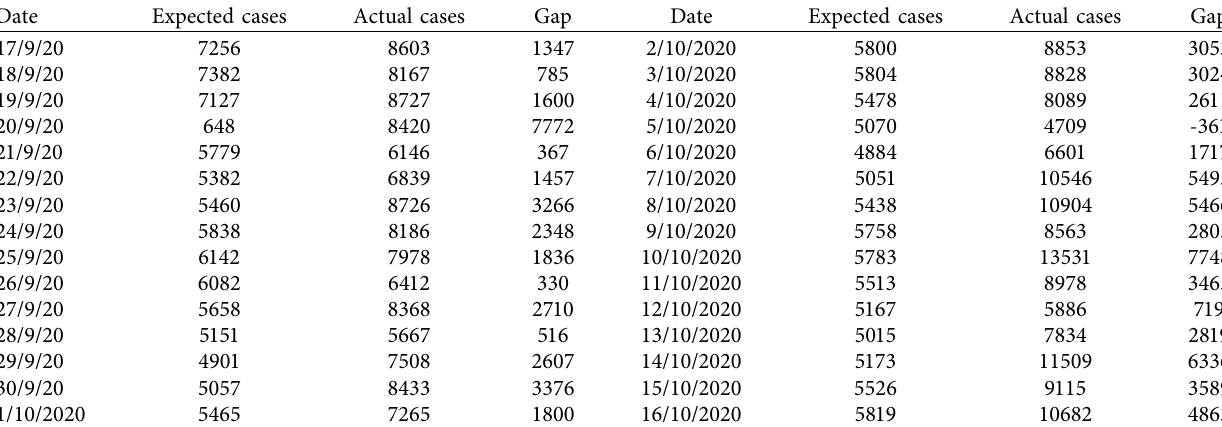
Table 9: The deviation between the actual and forecasted values of the daily confirmed COVID-19 cases in Africa for the period between 17/